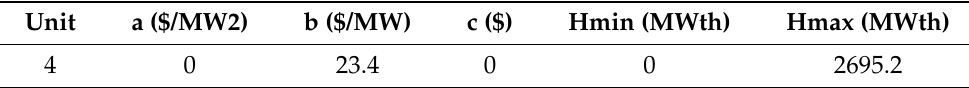
Table A3. Heat energy generator unit data for Case Study 1.